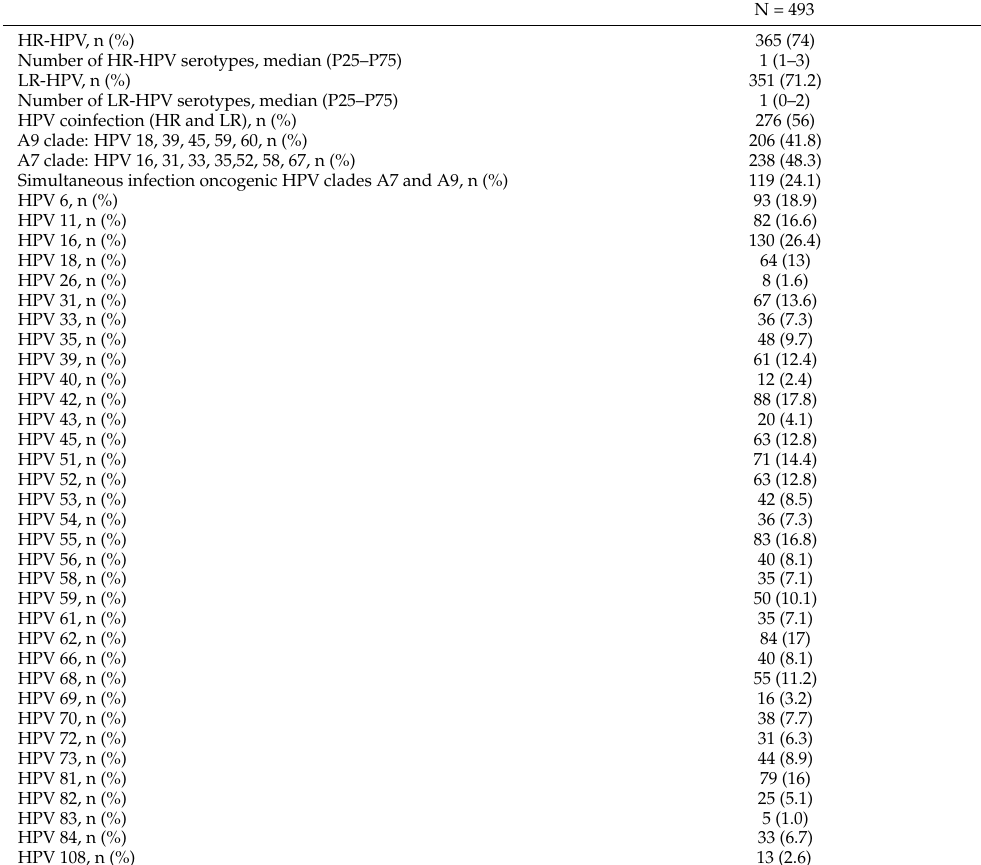
Table 3. HPV infection data at baseline visit.